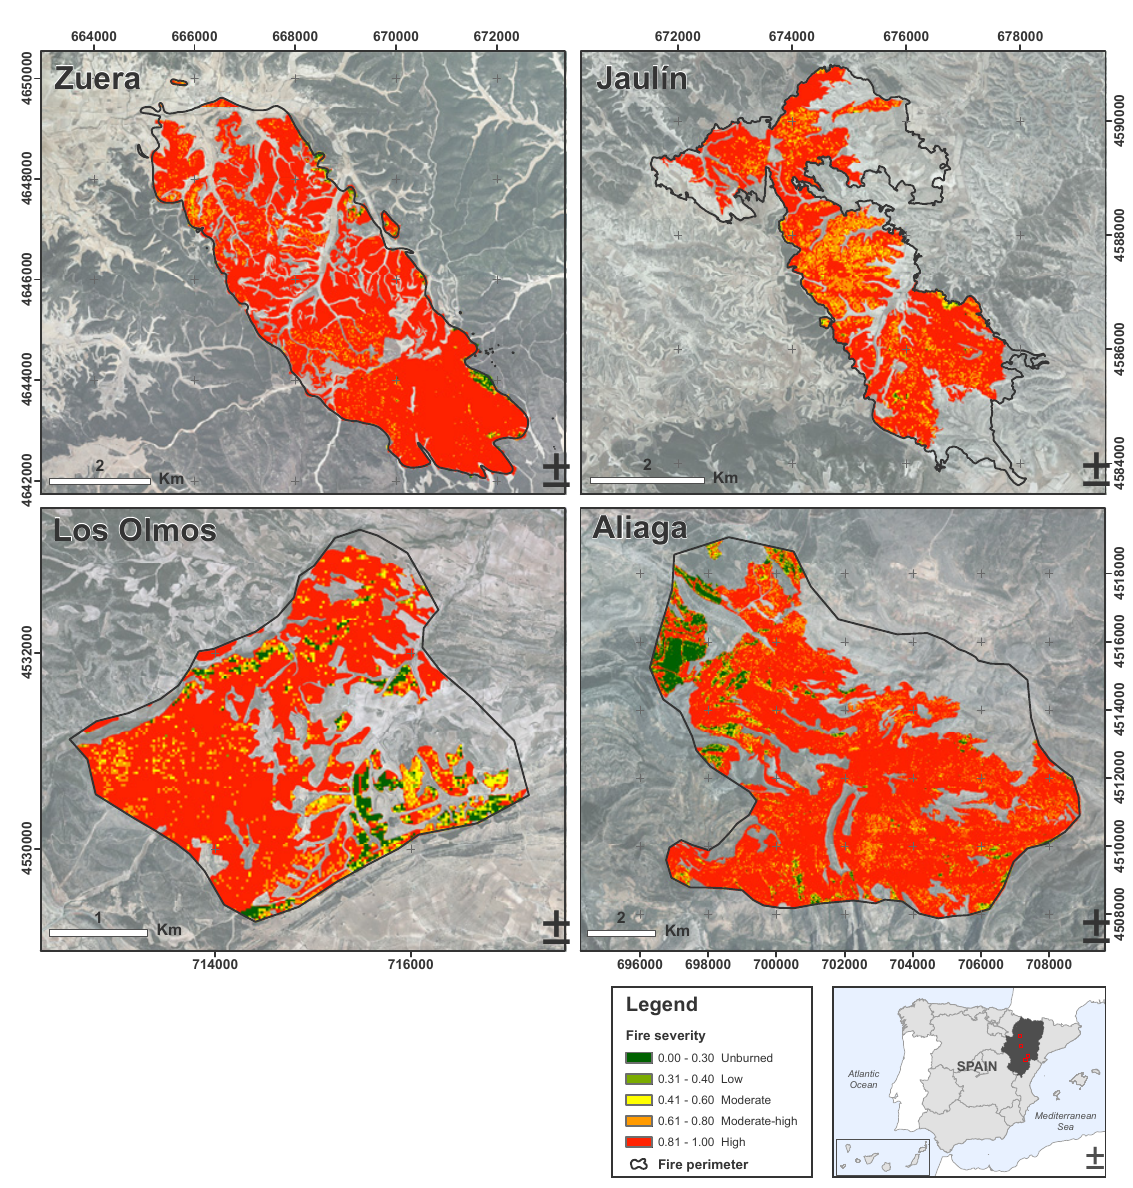
Figure 7. Fire severity maps obtained with the logistic method for pine cover in the four study locations. High spatial resolution ortophotography (2012) is used as